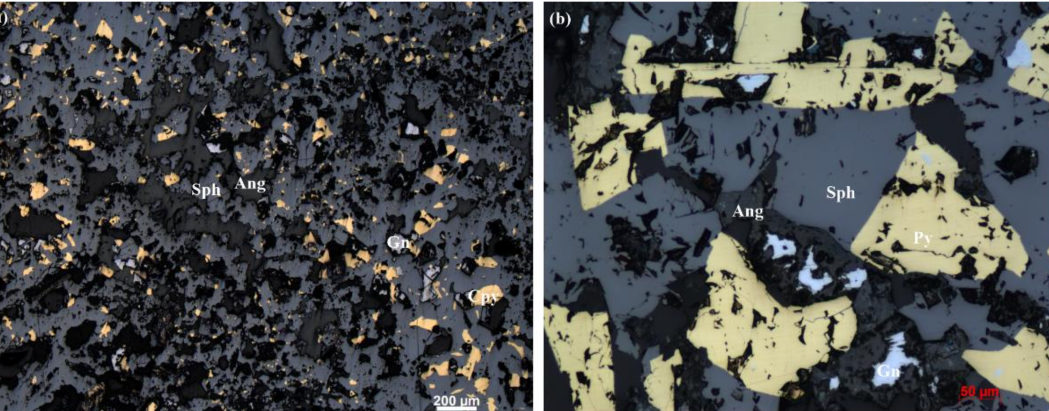
Figure 3. ( a ) Sphalerite forming large porous structures in sample H4-TVG10-2-1. Sphalerite with “dust” chalcopyrite disease condensing into larger particles. Pore centers with anglesite and galena infill indicates their later formation. ( b ) Intergrowth of subhedral to euhedral pyrite and spha- lerite forming large porous structures in sample H4-TVG10-2-1; pore center filled with anglesite. Relict galena surrounded by anglesite indicates secondary origin of anglesite replacing galena. (Ang = anglesite; Sph = sphalerite; Py = pyrite; Ccp = chalcopyrite; Gn =